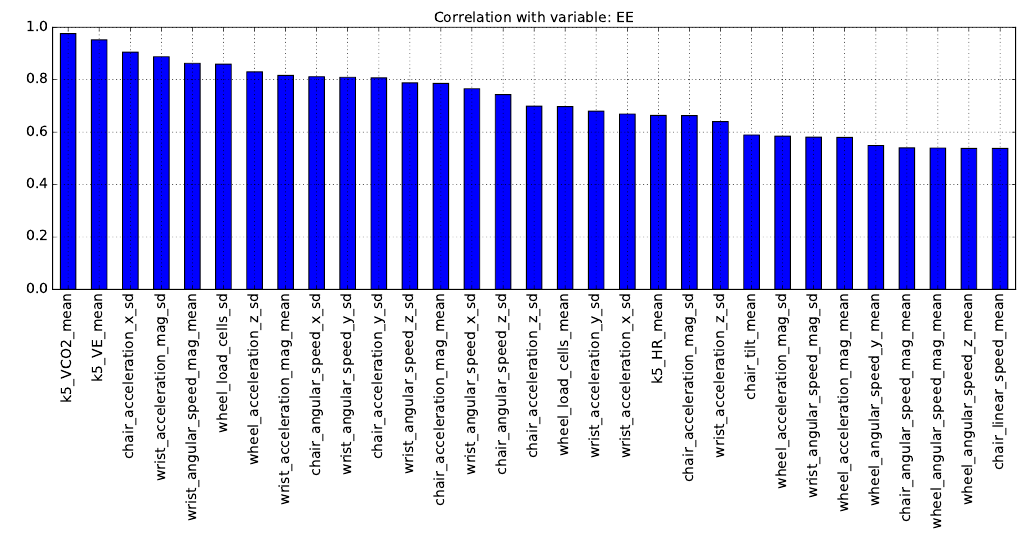
Figure 4. Highest correlation values between each available variable and the EE Table 5. F1-scores on training and validation datasets with manually selected features Training Set Validation Set Train Validation Dataset 1